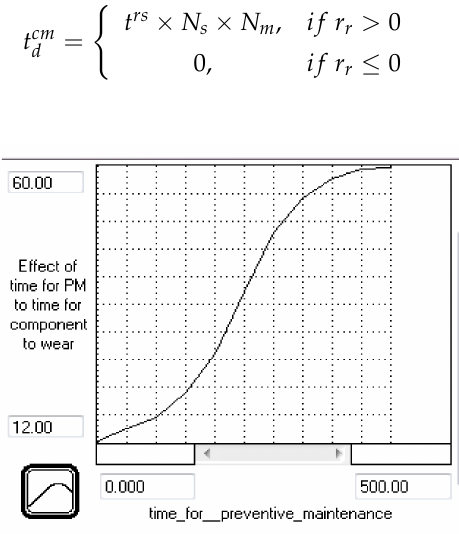
Figure 15. Effect of preventive maintenance time on the life of the